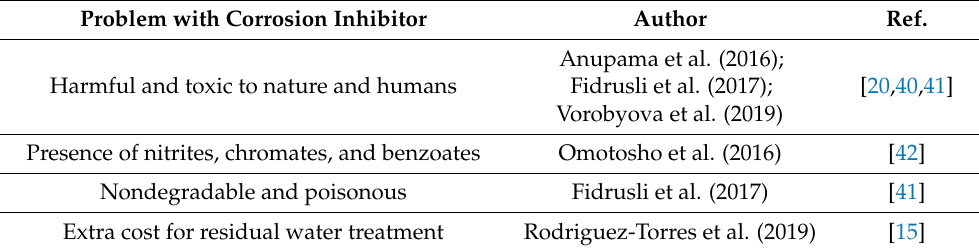
Table 1. Problem with conventional corrosion